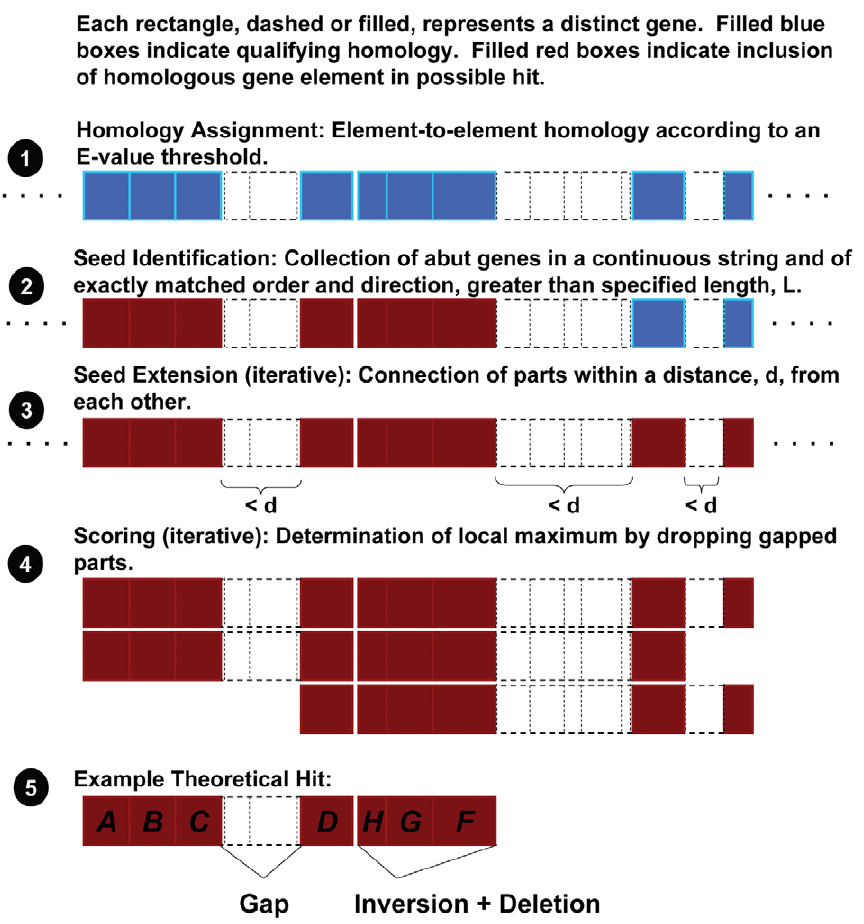
Figure 2. LMNAST heuristic. LMNAST operates in a BLAST-like manner, using the results of BLAST searches themselves as a curated database. 1. For each member of the query, in any nucleotide record, a homolog’s membership to a character type is assigned by scoring below a specified BLAST E-value threshold. Genes assigned to characters are highlighted blue. Genes without sufficient homology to any character are represented by dashed boxes. 2. Sufficiently long stretches of adjacent characters are identified as seeds (red). 3. Sufficiently proximal characters are connected to seeds or seeds are connected to each other when separated by a base pair distance , d. 4. Rearrangements, losses, and deletions are scored according to a standard similarity heuristic. Noncontinuous elements are dropped iteratively until a maximum score is achieved, arriving at… 5. An LMNAST hit.